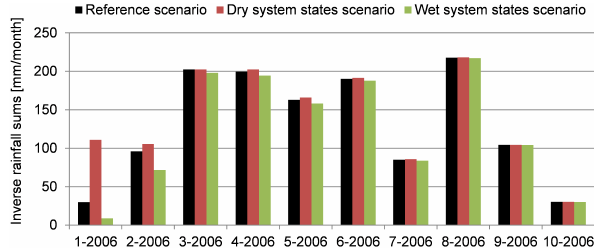
Figure 12. Krems catchment: monthly sums of inverse rainfall sim- ulated in the scenarios “reference”, “dry” and “wet” from Exp 6